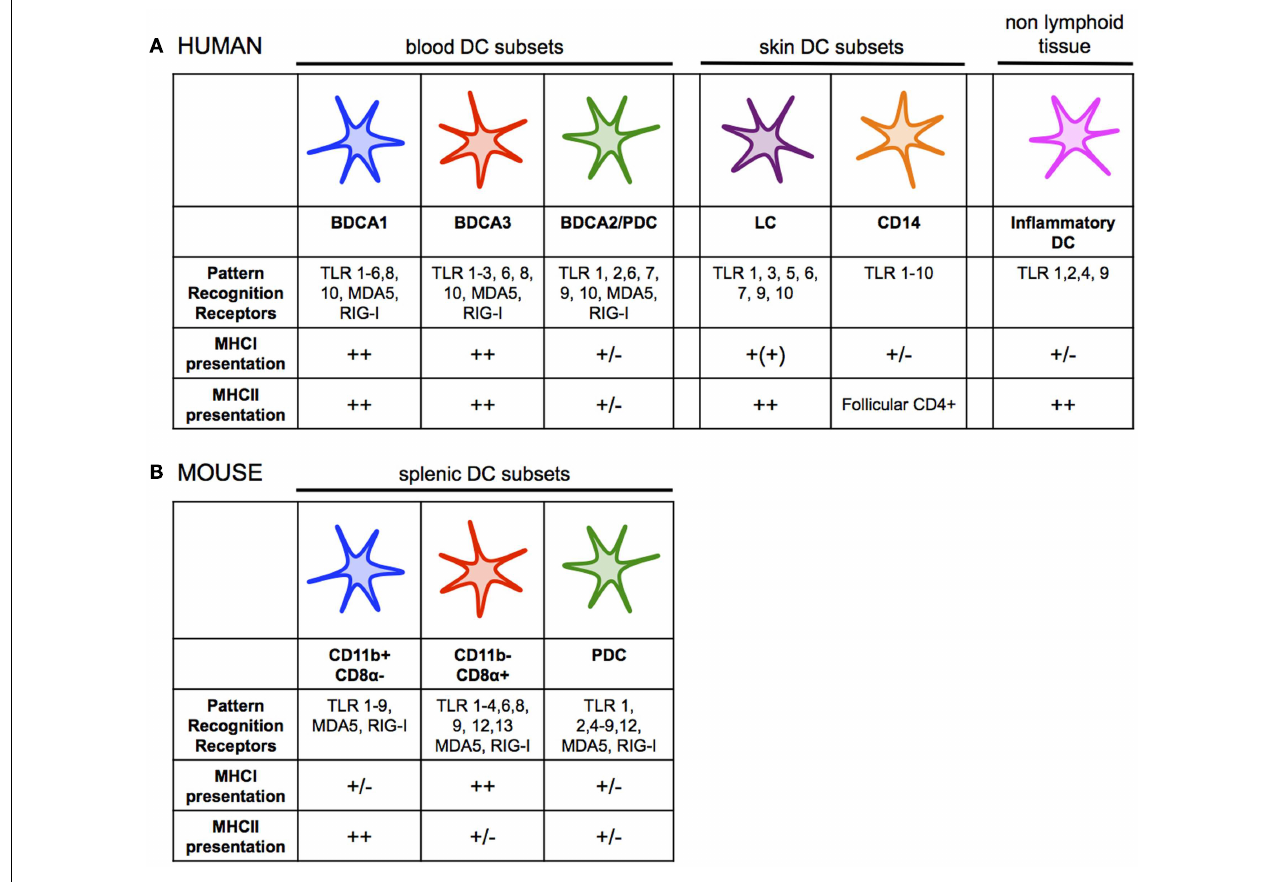
FIGURE 1 | (A) Human dendritic cell subsets have overlapping functions and phenotypes, but also show some degree of specialization. BDCA1 + DCs and BDCA3 + DCs both efficiently present antigen on MHCI and MHCII. pDCs can present antigen to CD4 + and CD8 + T cells, but likely their primary role in the immune response is the production of type I interferon during viral infection. LCs seem to be specialized for cross-presentation on MHCI, while CD14 + dermal DCs prime naïve CD4 + T cells to generate follicular helperT cells. Inflammatory DCs are monocyte-derived, and are present at sites of inflammation.There is also partial overlap between expression of PRRs among DC subsets.